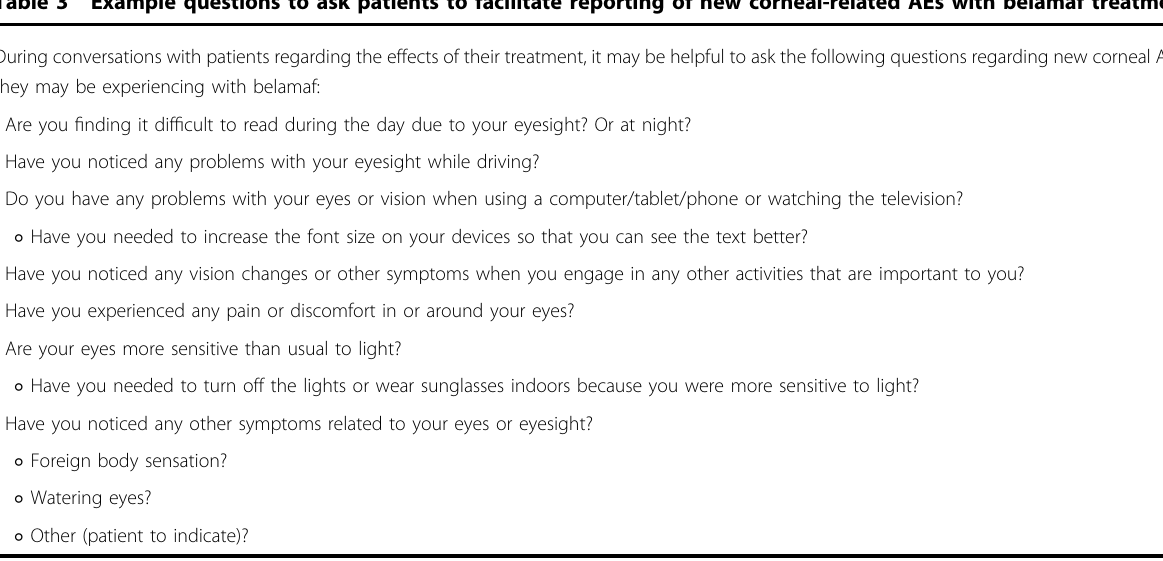
Table 3 Example questions to ask patients to facilitate reporting of new corneal-related AEs with belamaf treatment. During conversations with patients regarding the effects of their treatment, it may be helpful to ask the following questions regarding new corneal AEs they may be experiencing with